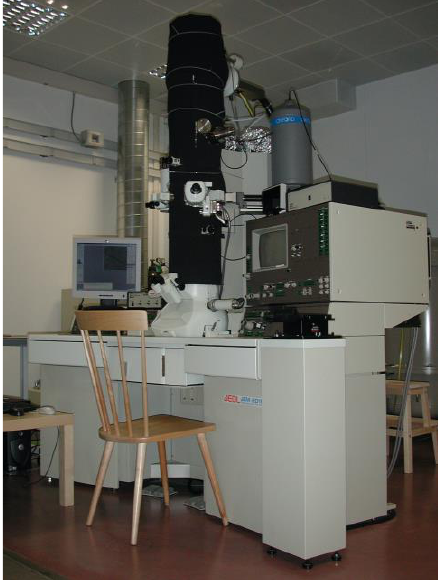
Figure 2. Photograph of one TEM/STEM laboratory at the ‘ Istituto Officina dei Materiali ’ of the Italian National Research Council (IOM CNR) in Trieste, showing a classic colonial wooden chair, which was used by the operator to prevent magnetic noise during the experiments.